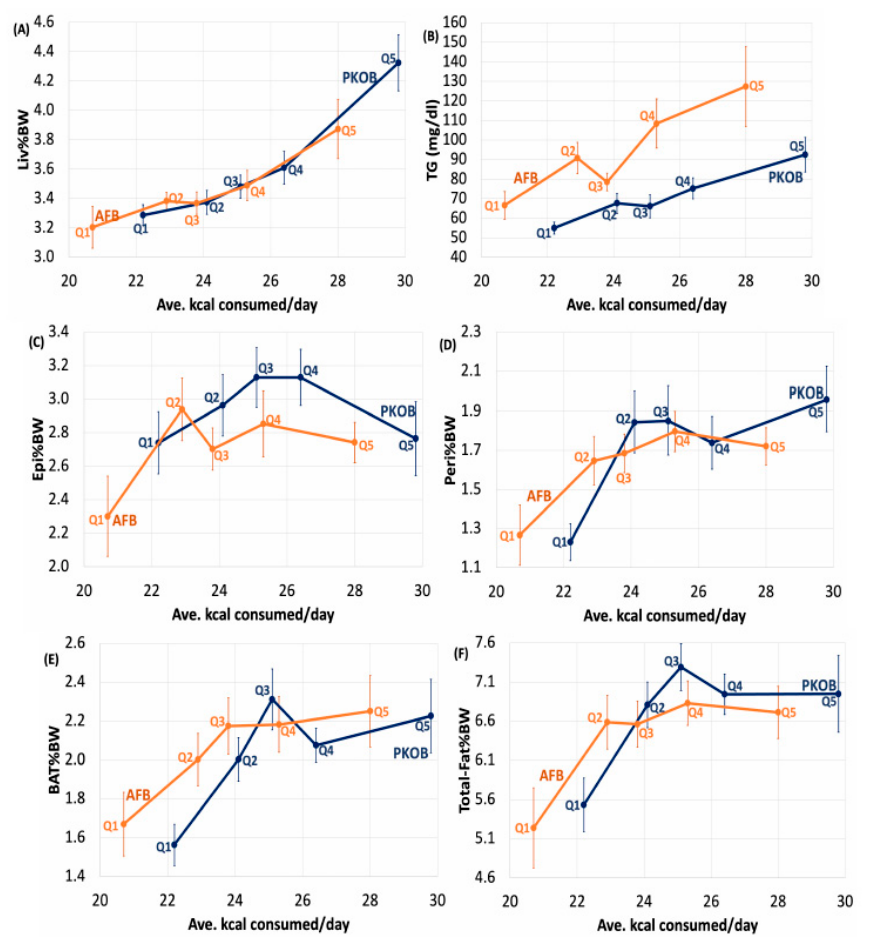
Figure 7. Necropsy and plasma TG data for rats fed either PKOB (blue) or AFB (orange) are ranked according to quintiles of kcal/d on the X-axis. ( A ) Liver as %BW reveals a steady increase for both fats as kcal/day intake increased, more pronounced for PKOB than AFB. Liver weight tracked BW as depicted in Figure 6A. ( B ) Terminal plasma TG, although not severe, revealed greater triglyceridemia for AFB than PKOB at all Q kcal , reflecting their P/S ratios of 0.35 and 1.0 for the two fats, respectively. ( C ) Rats fed PKOB accumulated more epididymal fat than AFB rats at all quintiles, except